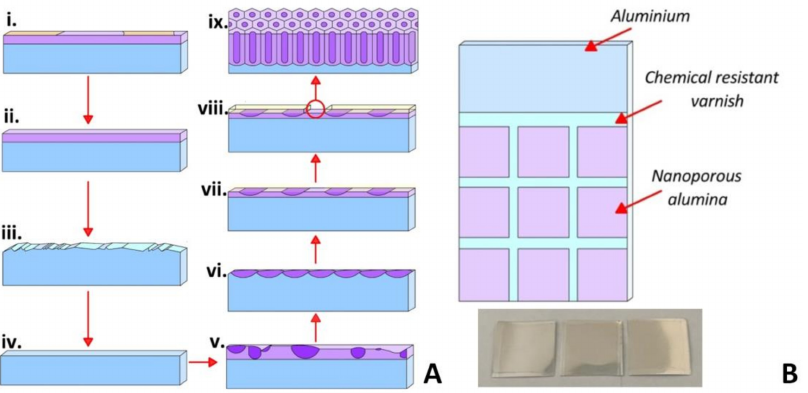
Figure 1. Scheme of the PAA fabrication process using two-step anodization for an ordered PAA formation ( A ); schematic view and Al substrate image for the PAA membranes obtaining ( B ).